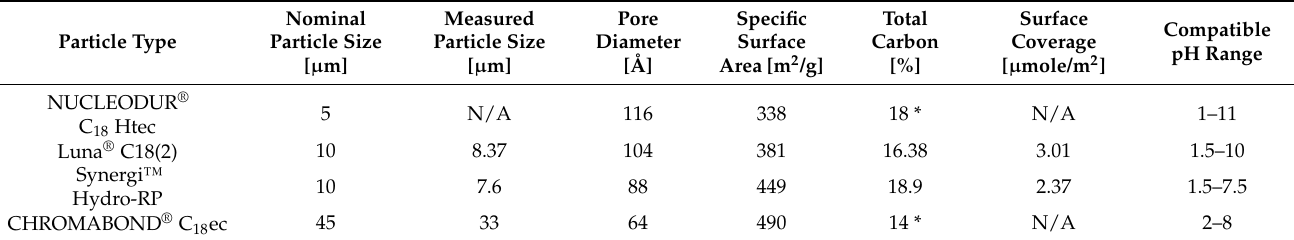
Table 2. Characteristics of particles used to prepare TFME